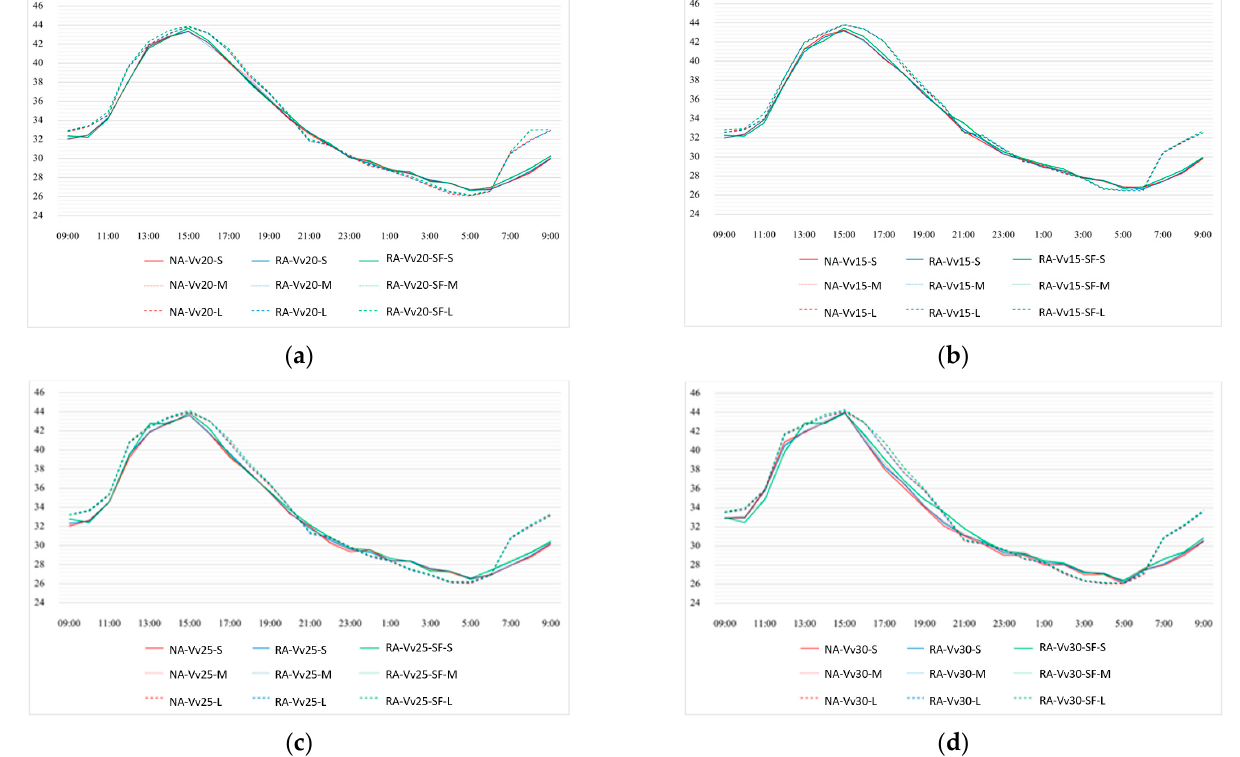
Figure 9. Temperature variation in PPCC specimens with ( a ) a 15% air void ratio, ( b ) a 20% air void ratio, ( c ) a 25% air void ratio, and ( d ) a 30% air void ratio.